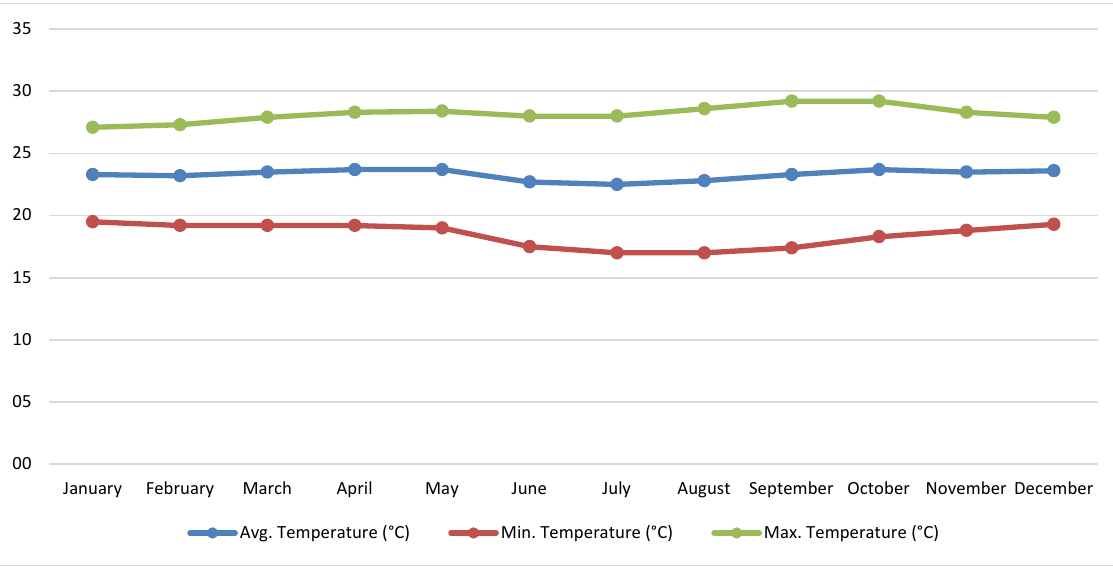
Fig. 1. The result of monthly temperature statistics at Bandung Regency 2008-2019